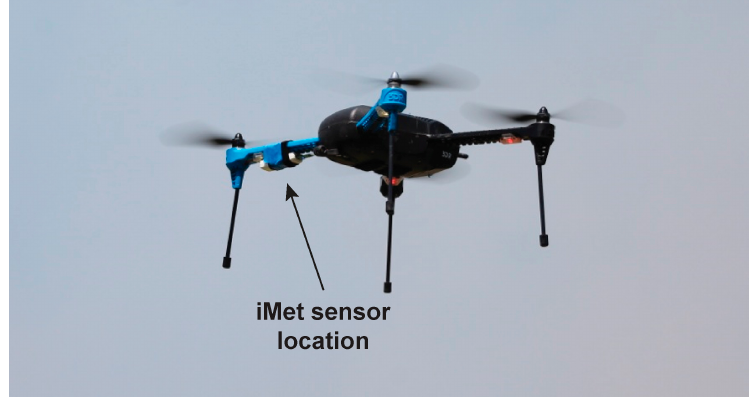
Figure 2. Location of iMet XQ sensor mounted on underside of 3DR Iris+ multirotor platform.